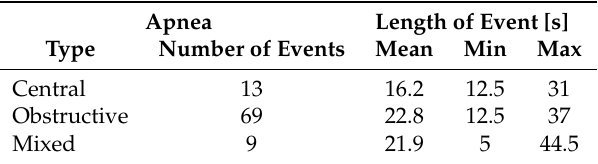
Table 4. Overview of apnea events.